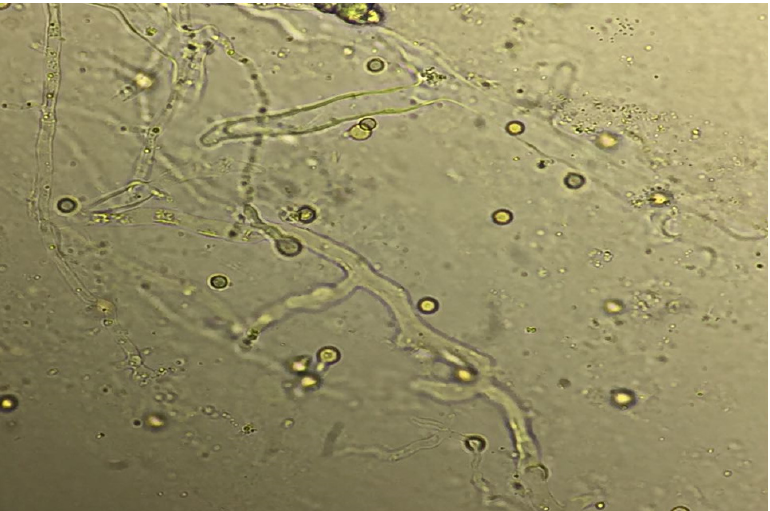
Figure 5. Broad aseptate hyphae indicating the Mucorales species seen on KOH stain of bron- choalveolar lavage (BAL) fluid. olar lavage (BAL)